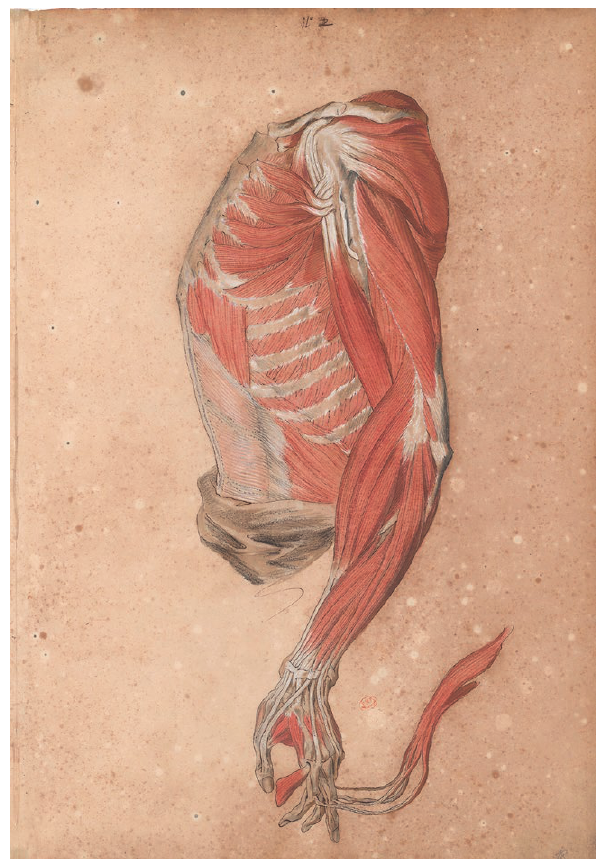
Figure 2 . Muscles and tendons of the human shoulder and arm as described by Johannes Van Horne and illustrated in colour by Mar- ten Sagemolen in Leiden, appr. 1660